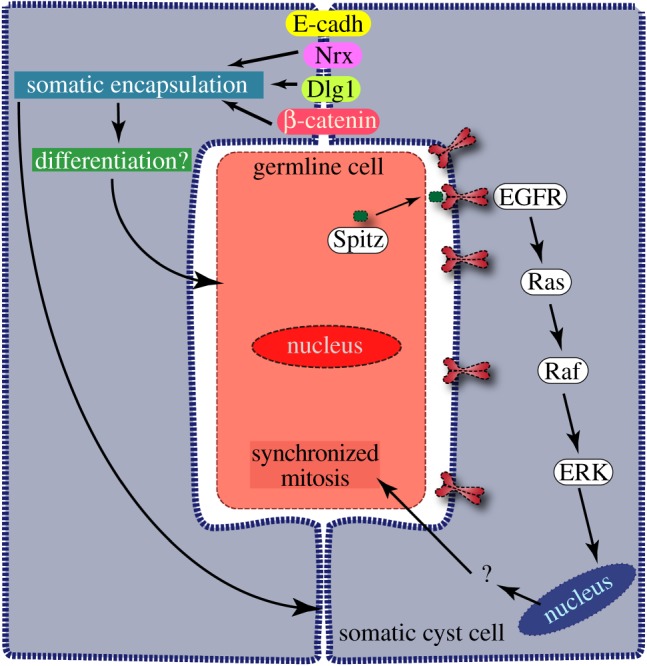
Schematic summary of the results and conclusions. Secretion of Spitz, an EGFR ligand, form the germline cells [23] activates EGFR on the somatic cyst cell membrane [9]. It induces the phosphorylation of the MAPkinase, ERK, which in turn helps to synchronize the germline divisions within a cyst and facilitates the transition to the spermatocyte stage. Cell adhesion proteins β-catenin, Discs-large-1 (Dlg1) and Neurexin IV (Nrx) help to form a tight somatic enclosure around the germline cyst that is essential for differentiation after the spermatocyte stage.